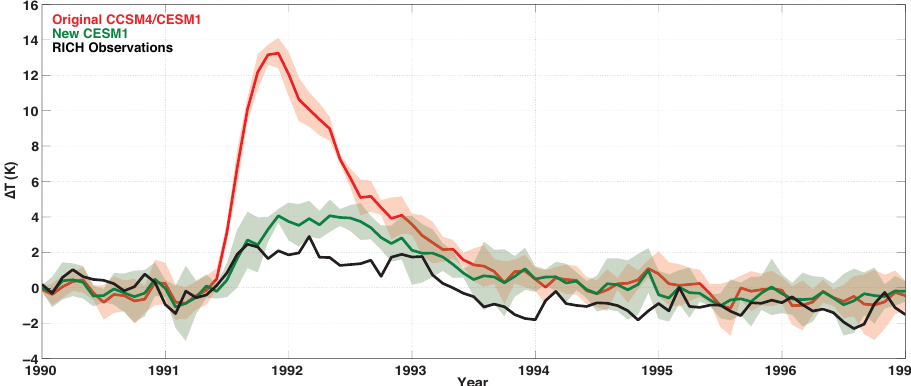
Figure 6. Tropical (20 ◦ S to 20 ◦ N), monthly, ensemble, and mean temperature anomaly at 50hPa following the simulated Mt. Pinatubo eruption in June of 1991. Anomalies are referenced to the 1990 annual mean in each ensemble member. Shaded regions represent the ± 1 σ standard deviation of the ensemble. The RICH data observations (black) come from Haimberger et al.